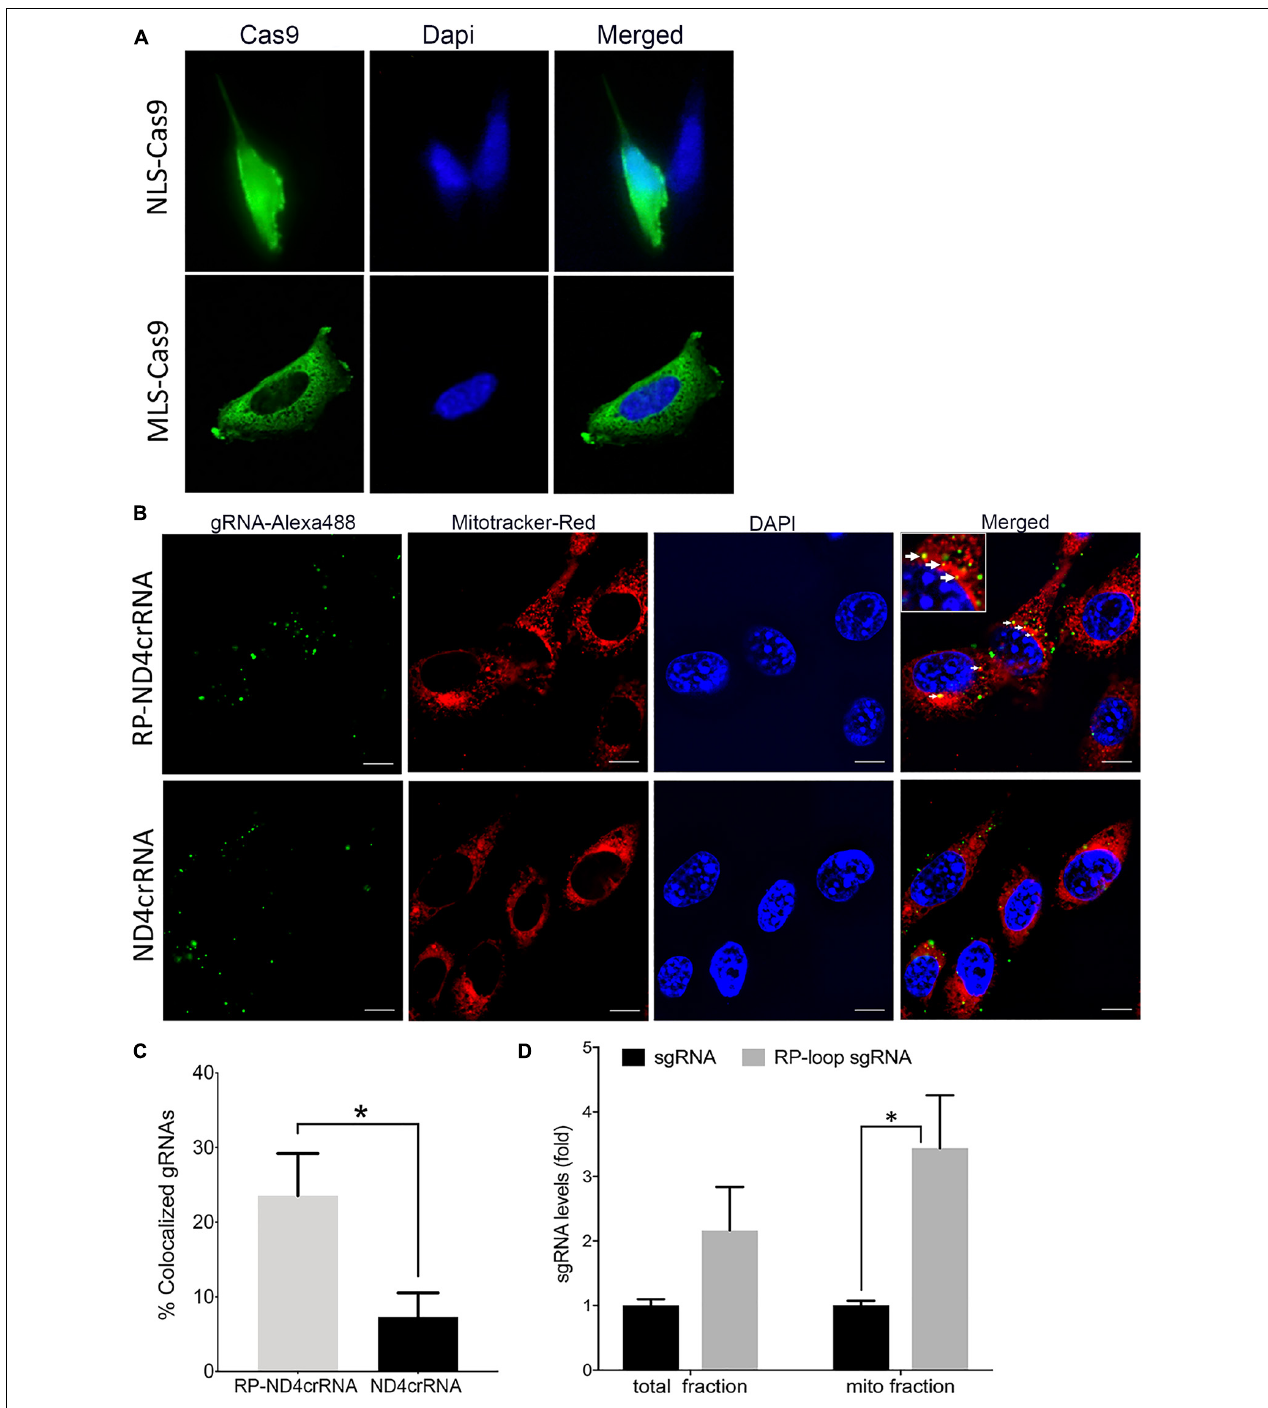
FIGURE 2 | Delivery of CRISPR–Cas9 complex into the mitochondria. (A) Immuno-staining showed that at 24 h posttransfection, mitochondria-targeting Cas9 constructs (MLS)–Cas9 predominantly localized in the cytoplasm, whereas nuclear localization signal (NLS)–Cas9 went to the nucleus. (B) Mouse embryonic fibroblast (MEF) cells were transfected with Alexa flour 488 tagged ND4crRNA and RP-ND4crRNA, and the mitochondria were stained after 18 h with MitoTracker R (cid:13) Deep Red FM. Cells were mounted in Vectashield anti-fade mounting media with DAPI (Vector Laboratories), and images were taken at 100 × magnifications using Nikon Ti2-E inverted microscope; scale bar: 10 µ m. (C) Cells with mitochondrial colocalized gRNA (solid arrows in B ) were counted at 20 × magnification showed enhanced percentage of RP-ND4crRNA merged with mitochondria ( n = 3, Student’s t -test, p = 0.01). (D) RP loop increases the levels of sgRNA detected in the mito fractions. qPCR was performed, and levels of sgRNA were normalized to mitochondrial ND4 and ND1 as internal controls and reported as fold change 2 (cid:49)(cid:49) CT ( n = 3, Student’s t -test, * p < 0.05).